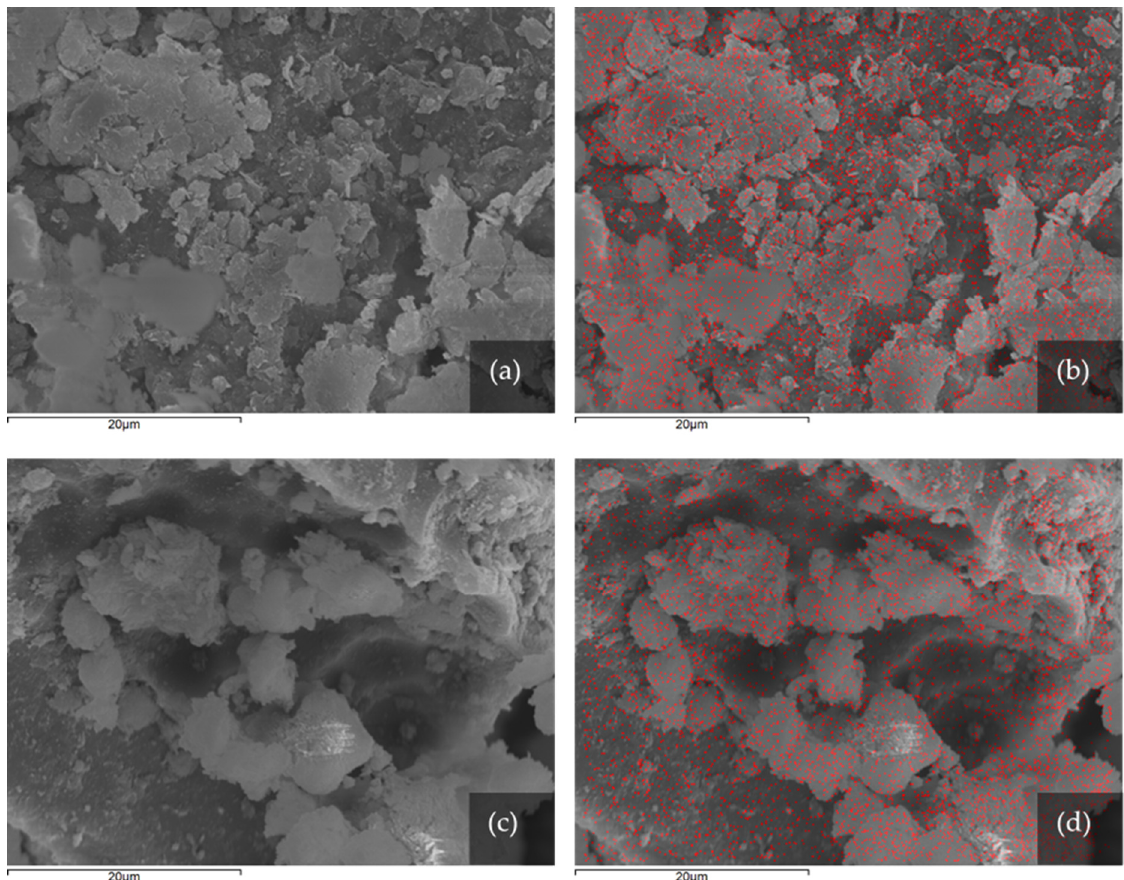
Figure 3. SEM photomicrographs showing before (left) and after (right) elemental mapping of ( a , b ) ZnBent and ( c , d ) CuBent, respectively. The distribution of zinc and copper, respectively, is indicated by red dots. Table 2. Trace element composition (ppm) (XRF) of Bent, ZnBent, and CuBent powder samples.